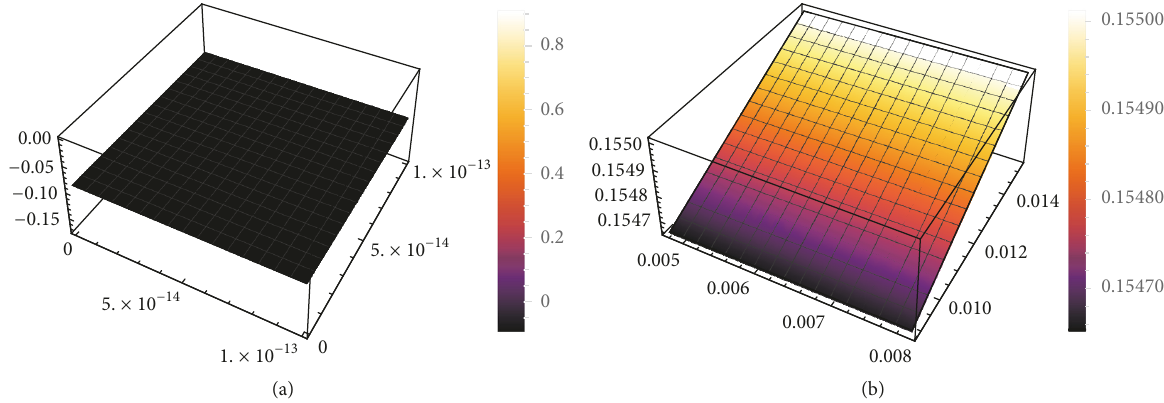
Figure 2: (a) The direct 𝐶𝑃 violation as a function of 𝜀 1 and 𝜀 2 from the effects of isospin symmetry for the decay process of 𝐵 𝑠 󳨀→ 𝜋 0 𝜂 . (b) The same as (a) from the effects of isospin symmetry breaking. The horizontal axis and vertical axis refer to the values of 𝜀 1 and 𝜀 2 , respectively.